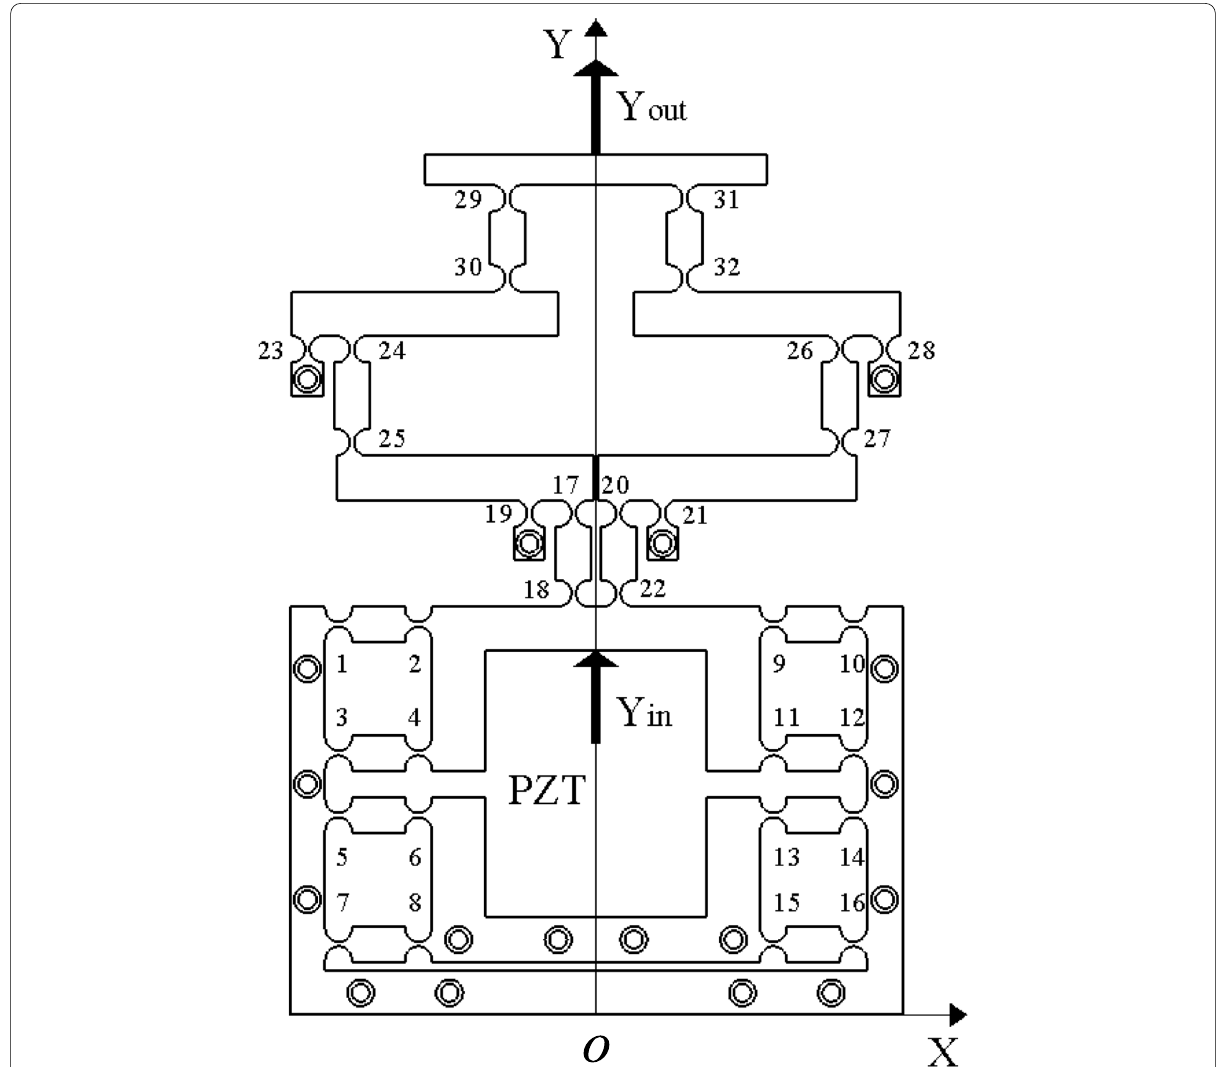
Fig. 6 Working principle diagram of two-stage amplification micro-drive mechanism